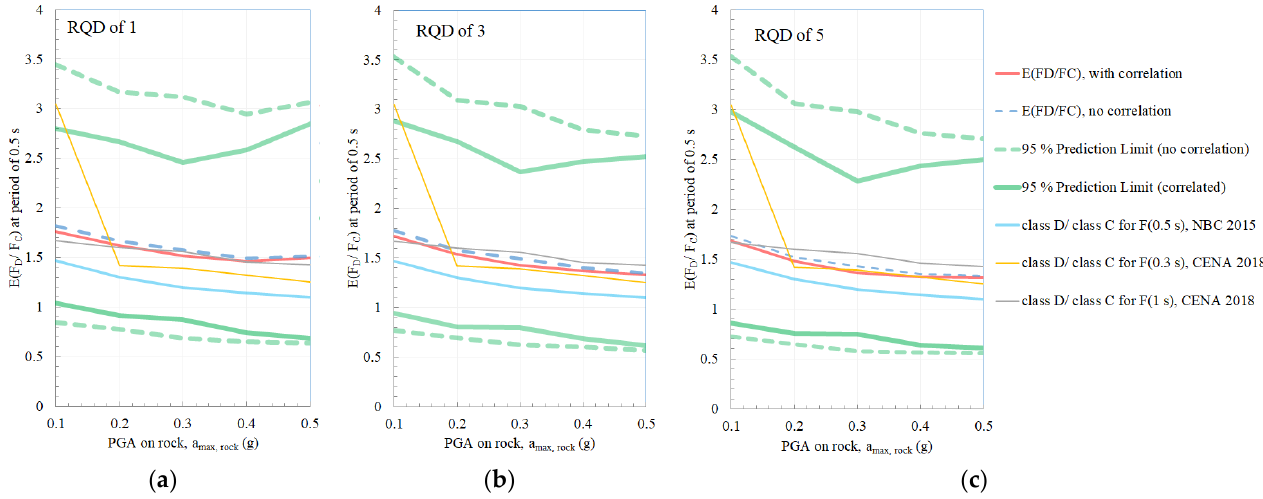
Figure 20. Comparison between (F D /F C ) at T = 0.5 s and the site factors in NBCC (2015) and the CENA site factors published by Hashash et al. [11] for RQD of 1 ( a ), 3 ( b ) and 5 ( c ).